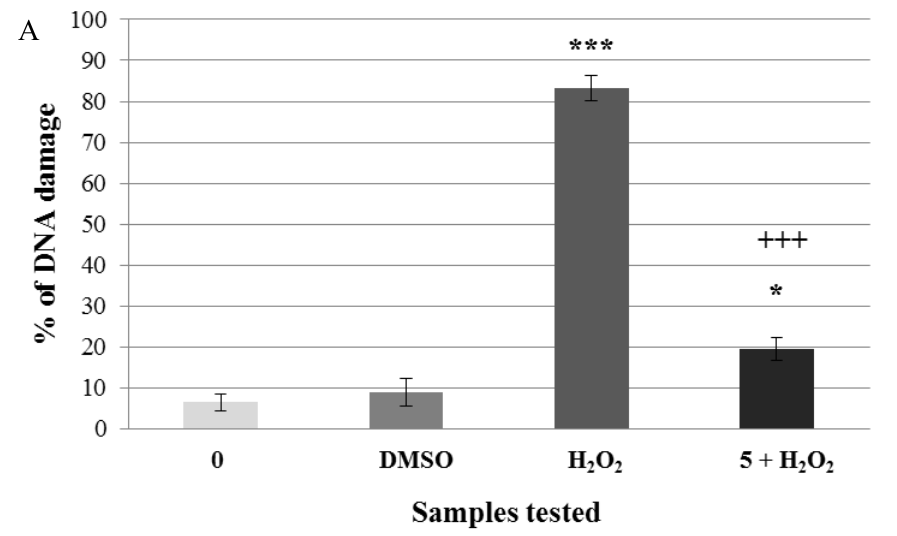
Figure 5. Pre-incubation of lymphocytes with a non-genotoxic concentration of flavonoids (A = kaempferol, B = quercetin). Legend for the x axis: 0 = negative control